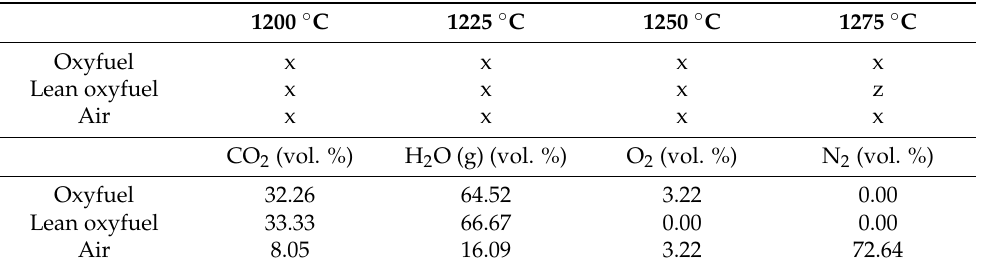
Table 2. Research experiment matrix and the compositions of the used atmospheres. For x: TG,field- emission scanning electron microscope energy dispersive X-ray (FESEM), glow discharge optical emission spectrometer (GDOES) analysis; for z: TG, FESEM